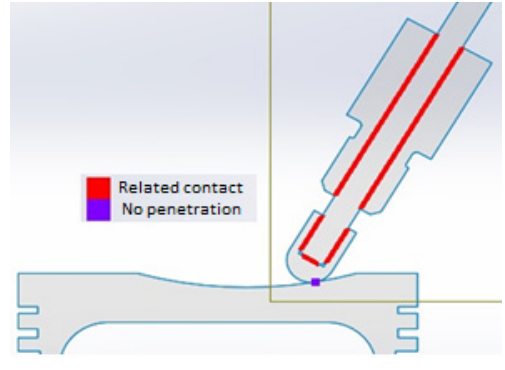
Figure 14. Contact